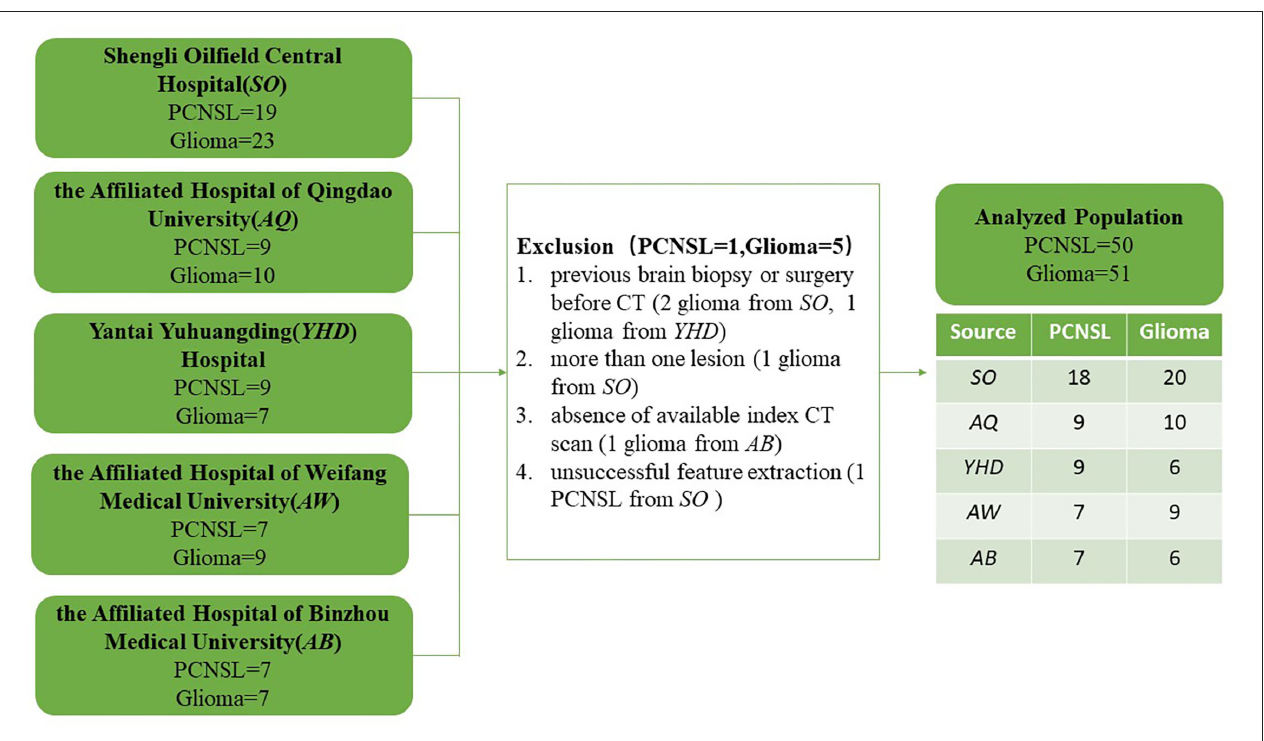
FIGURE 1 | Detailed inclusion and exclusion flowchart.